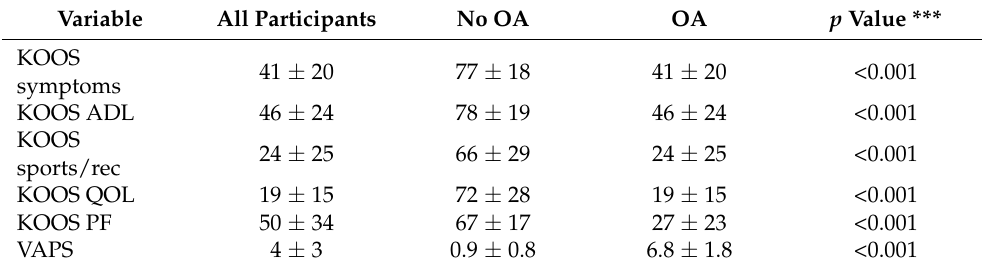
3 of 11 Table 1. Participants’ demographics, KOOS score, and visual analog pain score.